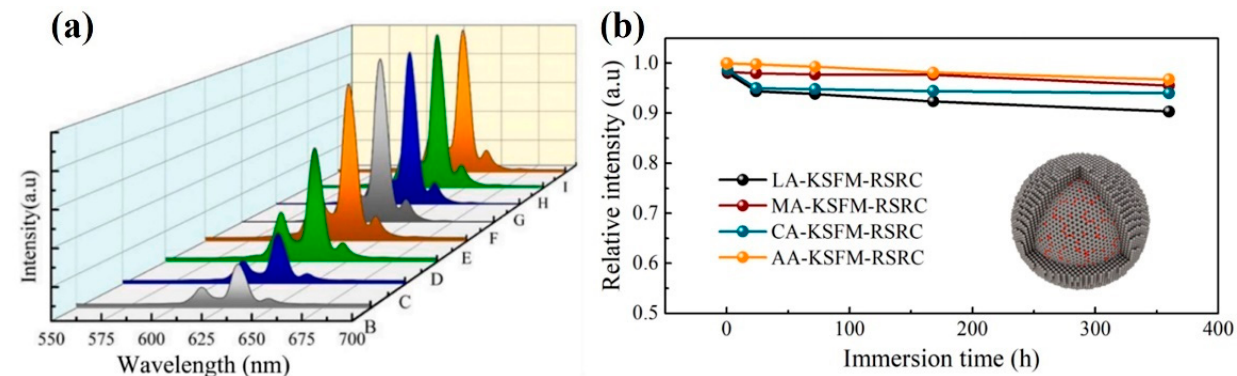
Figure 18. ( a ) PL spectra of KSFM (F, G, H, I) and after boiling in water (B, C, D, E) for 20 min, (B, F) KSFM, (C, G) KSFM-CE, (D, H) KSFM-SP, (E, I) KSFM-RSRC; ( b ) Relative PL intensities of KSFM-RSRC treated with LA, MA, CA and AA immersed in water for different times. (Reprinted from Ref [29]. Copyright from Elsevier, 2021).